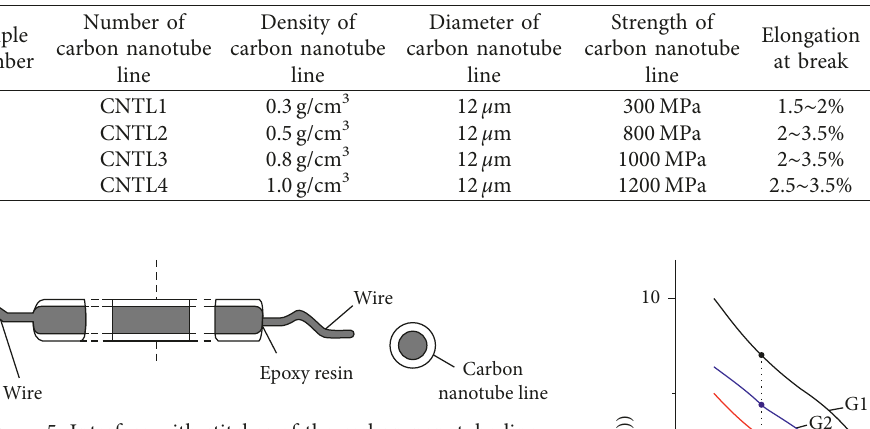
Table 1: Parameter configuration of the samples.